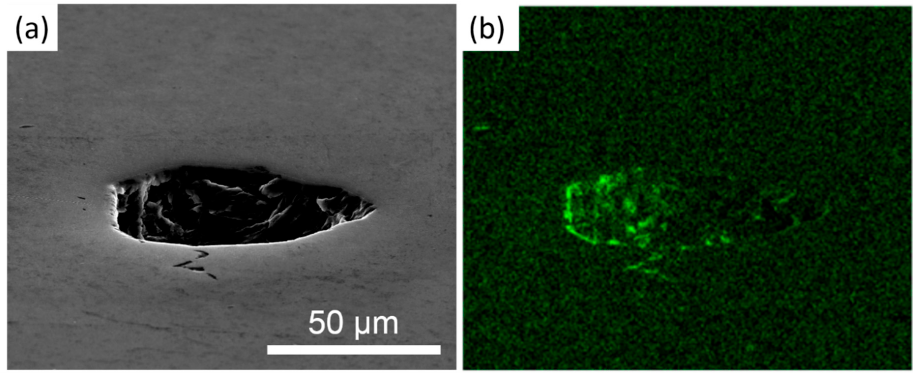
Figure 7. ( a ) SEM image of a pore of LFP-fabricated specimen and ( b ) its EDS mapping of oxygen content.